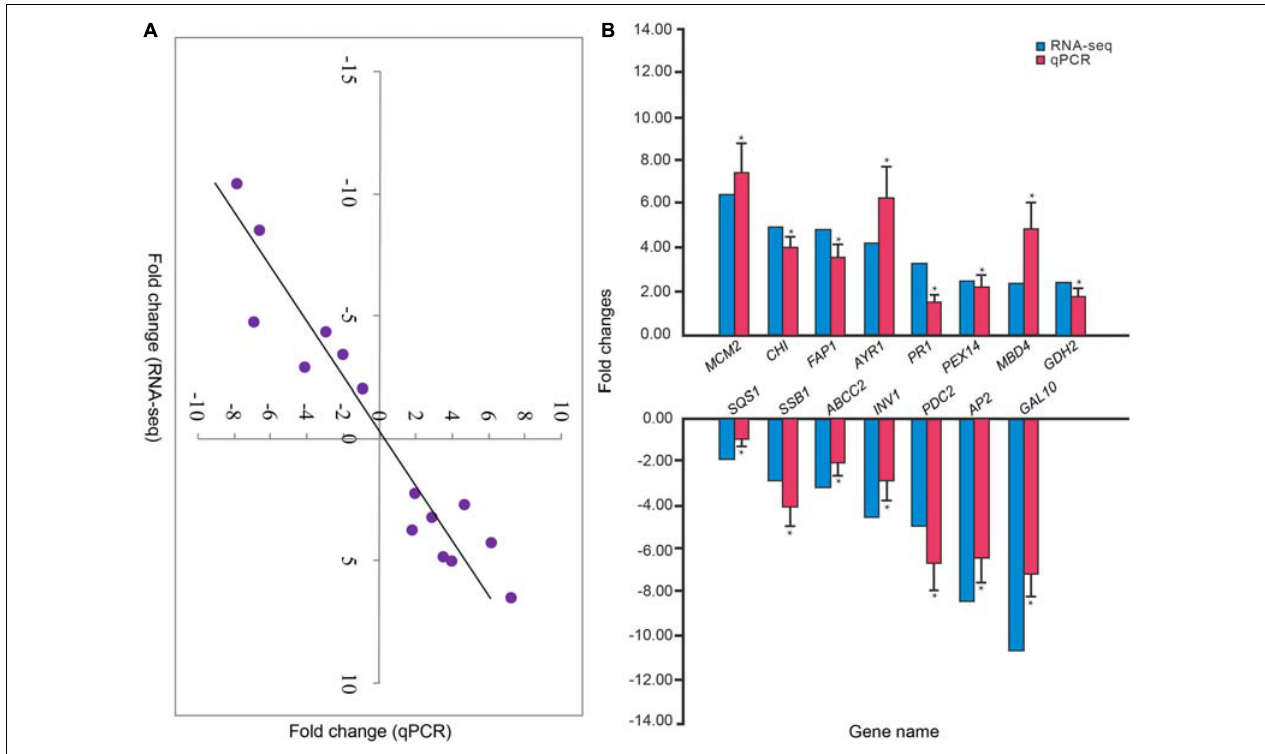
FIGURE 4 | (A) Correlation between the relative fold changes in expression from RNA sequencing and qPCR analyses. (B) The relative fold changes in expression of 15 genes in P. lilacinum infecting M. incognita eggs (treatment group) compared to P. lilacinum (control group). *Denotes a significant difference in relative fold changes in expression of treatment group compared to control group as determined by unpaired two-tailed t -test. * p < 0.01. Three technical replicates were conducted for each of the three biological